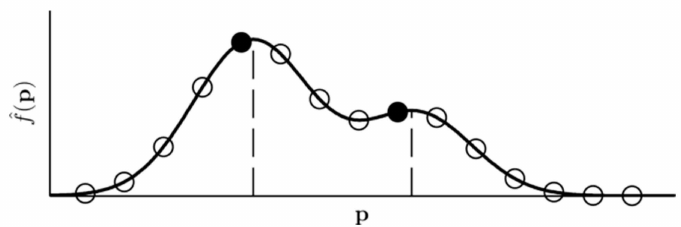
Figure 8. Final detection by evaluating the fused continuous density function at gridded points (circles) and finding local maxima (filled circles) among them. These hits approximate the true density modes (dashed